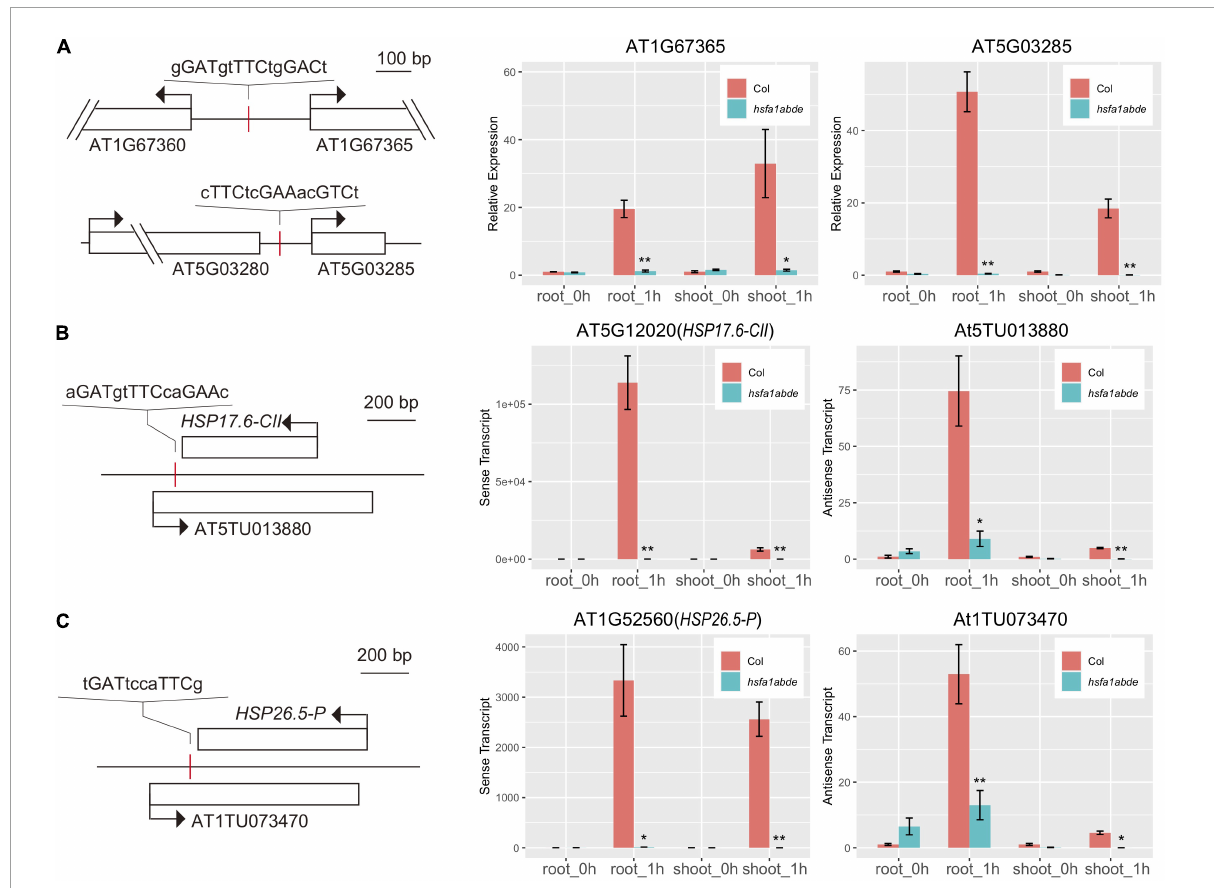
FIGURE4 Position of HSFA1 -binding sites and qRT-PCR for several lincRNAs and NAT pairs in hsfa1abde mutant. (A) Schematic diagram of structure and qRT-PCR results of genes encoding heat-inducible lincRNAs (AT1G67365 and AT5G03285). (B) Schematic diagram of structure and qRT-PCR results of genes encoding heat-inducible NAT pairs (HSP17.6CII-At5TU013880). (C) Schematic diagram of structure and qRT-PCR results of genes encoding heat-inducible NAT pairs (HSP25.6-At1TU073470). Red lines and open boxes indicate positions of HSE found around ChIP-seq peaks and gene bodies, respectively. Sequence of each HSE was shown above the red lines. At1TU073470 has non-canonical HSE (nGAAnnnnTTCn), whereas other genes have canonical HSE (double or triple inverted repeats of nGAAn). One conserved adenine in nGAAn and one conserved thymine in nTTCn are exchangeable with other nucleotides. * P < 0.05, ** P < 0.01 in two-tailed Student’s t -tests between Col and hsfa1abde . Error bars indicate SD ( n =